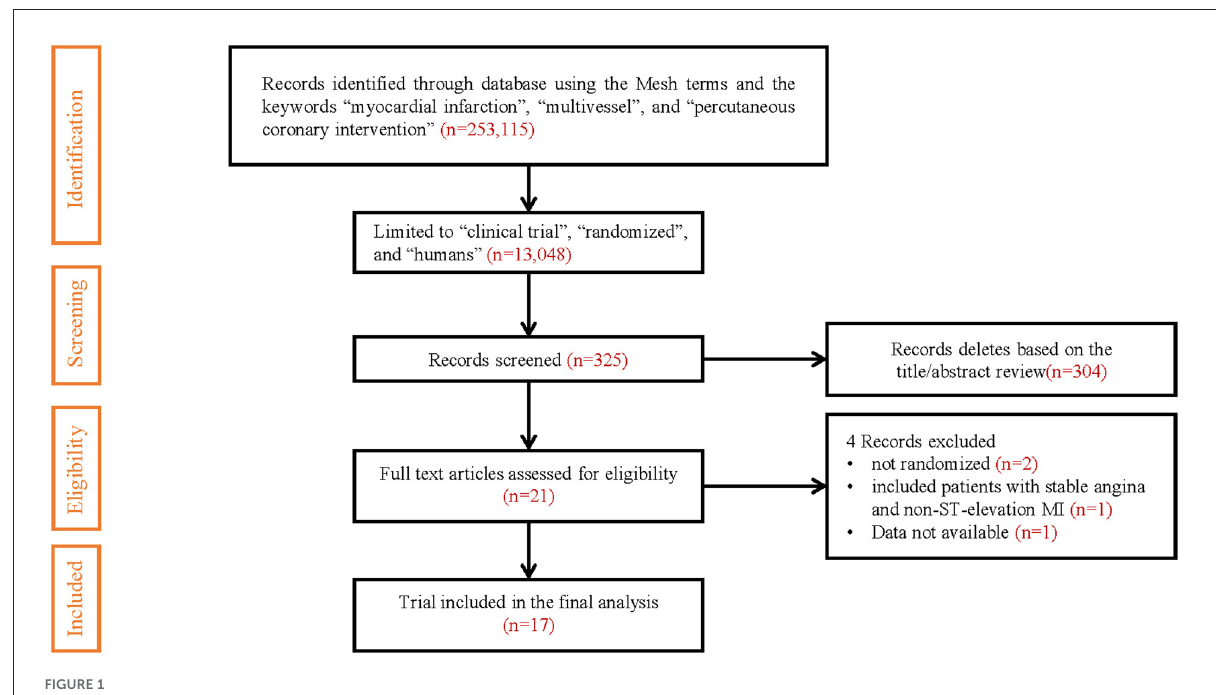
FIGURE1 PRISMA study search flow